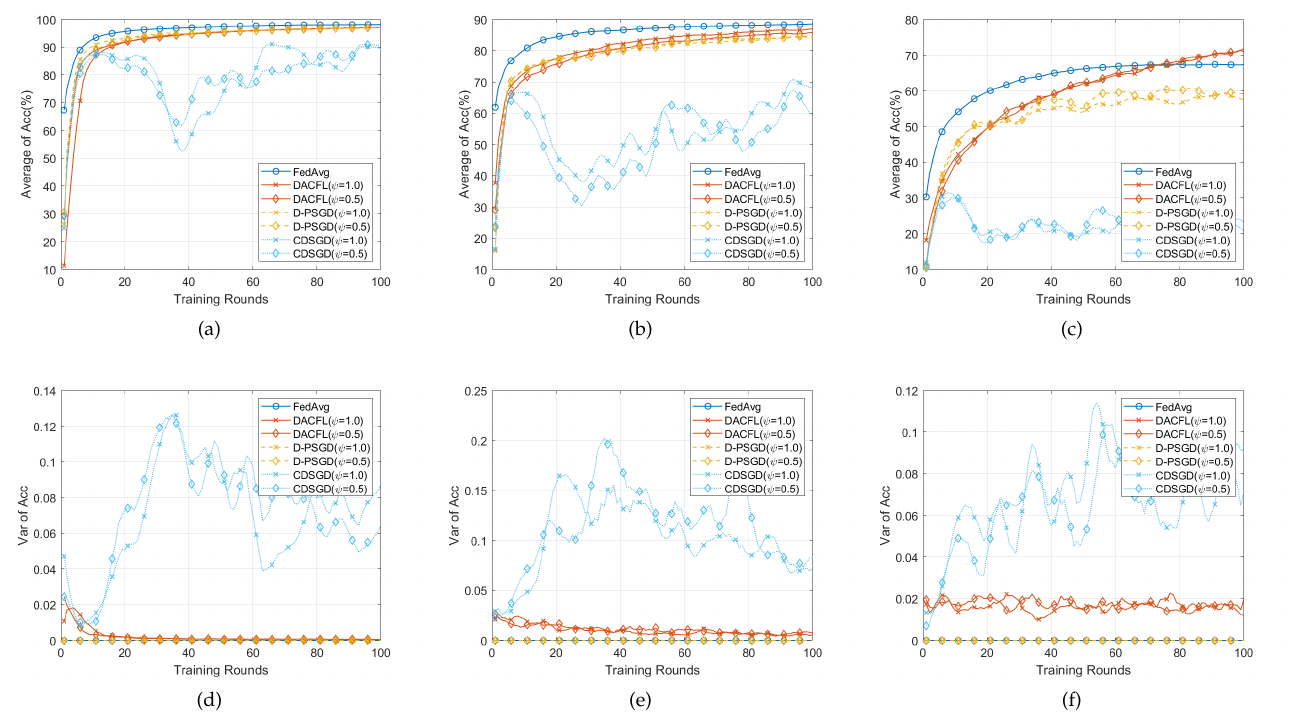
Figure 5. Performance comparison with i.i.d data and time-varying topology. ( a , d ) on MNIST; ( b , e ) on FMNIST; ( c , f ) on